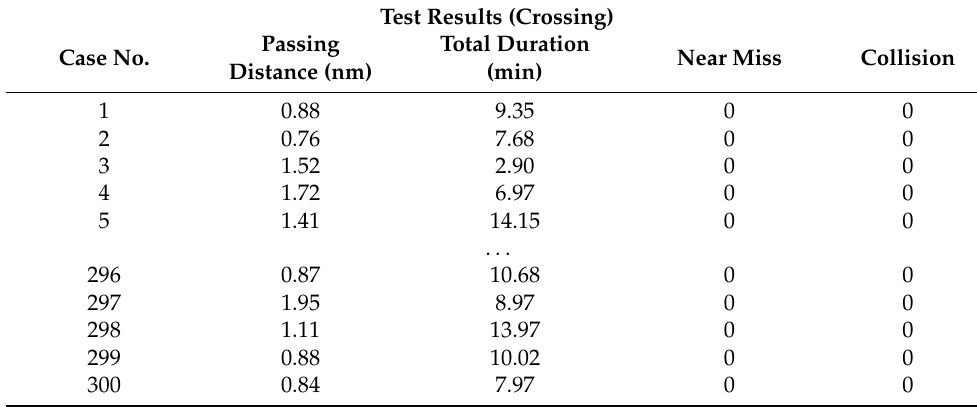
Table 8. Test results in crossing scenarios.